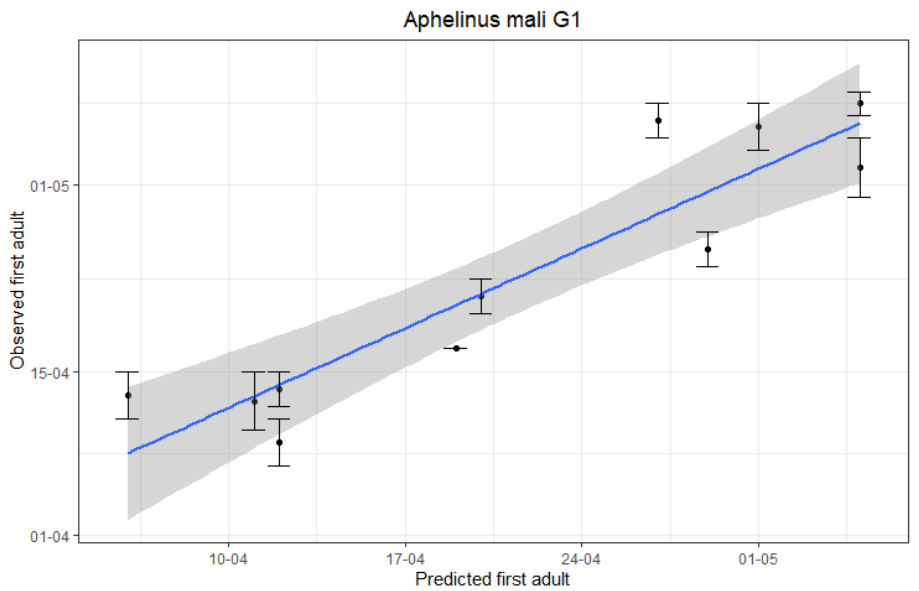
Figure 2. Linear regression analysis of predicted first-generation (G1) A. mali adults vs. observed first G1 A. mali adults by monitoring in apple orchards. Error bars represent the last date when yellow sticky monitoring plates were checked for which none of the checked plates showed caught A. mali adults and the first date that newly emerged A. mali adult(s) were detected on the monitoring plates.